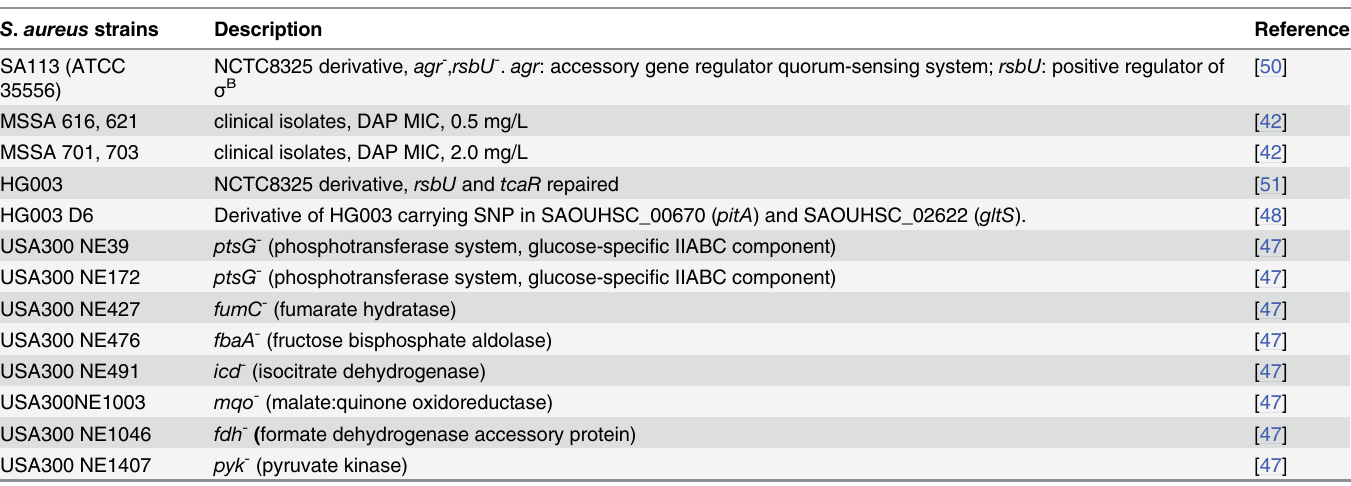
Table 1. List of strains used in this study. S . aureus